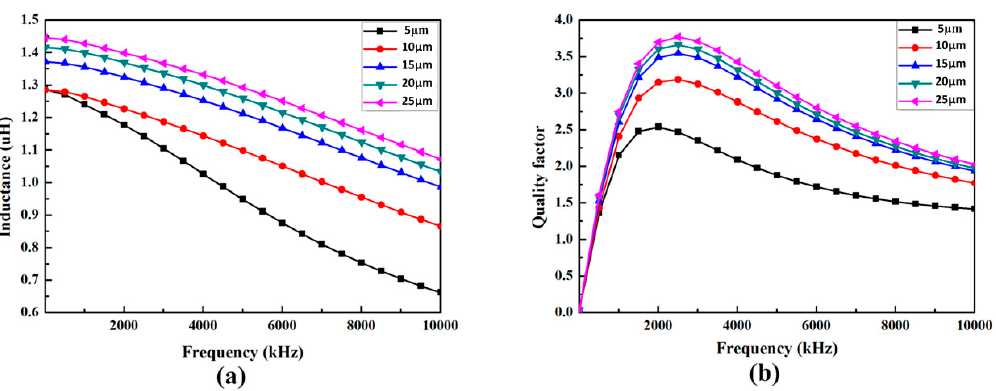
Figure 6. Effect of magnetic film’s thickness on the inductance and quality factor of the micro-inductor: ( a ) Inductance as a function of frequency; ( b ) quality factor as a function of frequency.